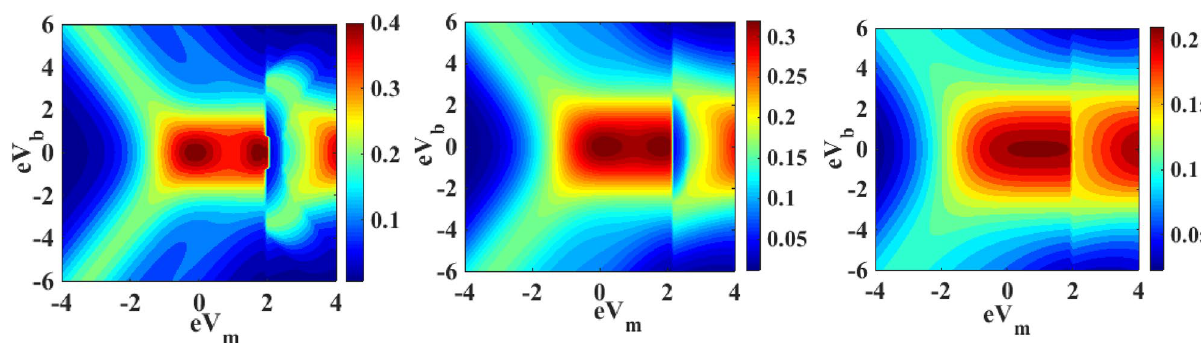
Figure 19. Map of G in the V b − V m — space for (cid:31) = 0.6 and U = 3 for ( a ) k B T = 0.4 ; ( b ) k B T = 0.6 ; ( c ) k B T = 0.8